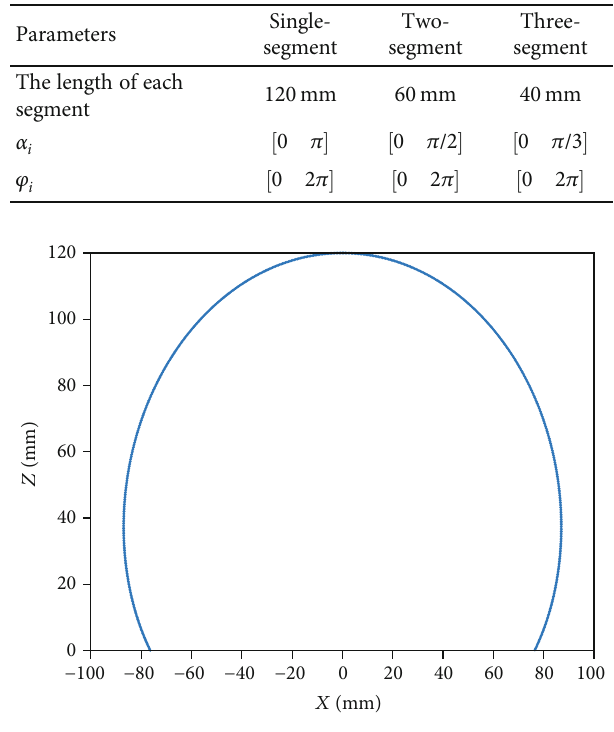
Figure 7: One-segment catheter workspace in